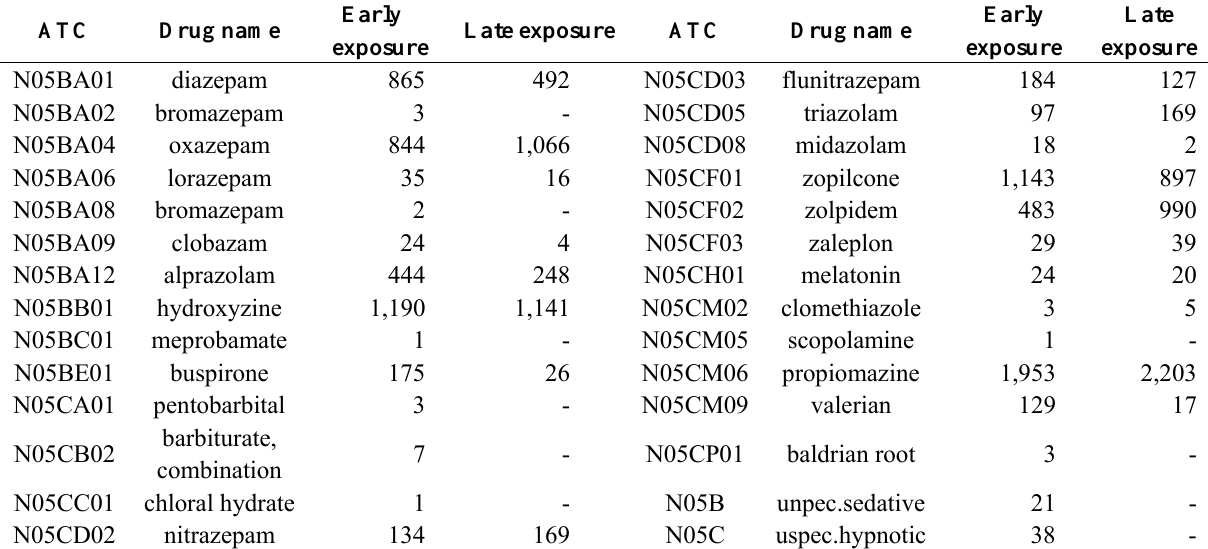
Table 23. Number of infants exposed in early pregnancy or during the 2nd or 3rd trimester for sedatives or